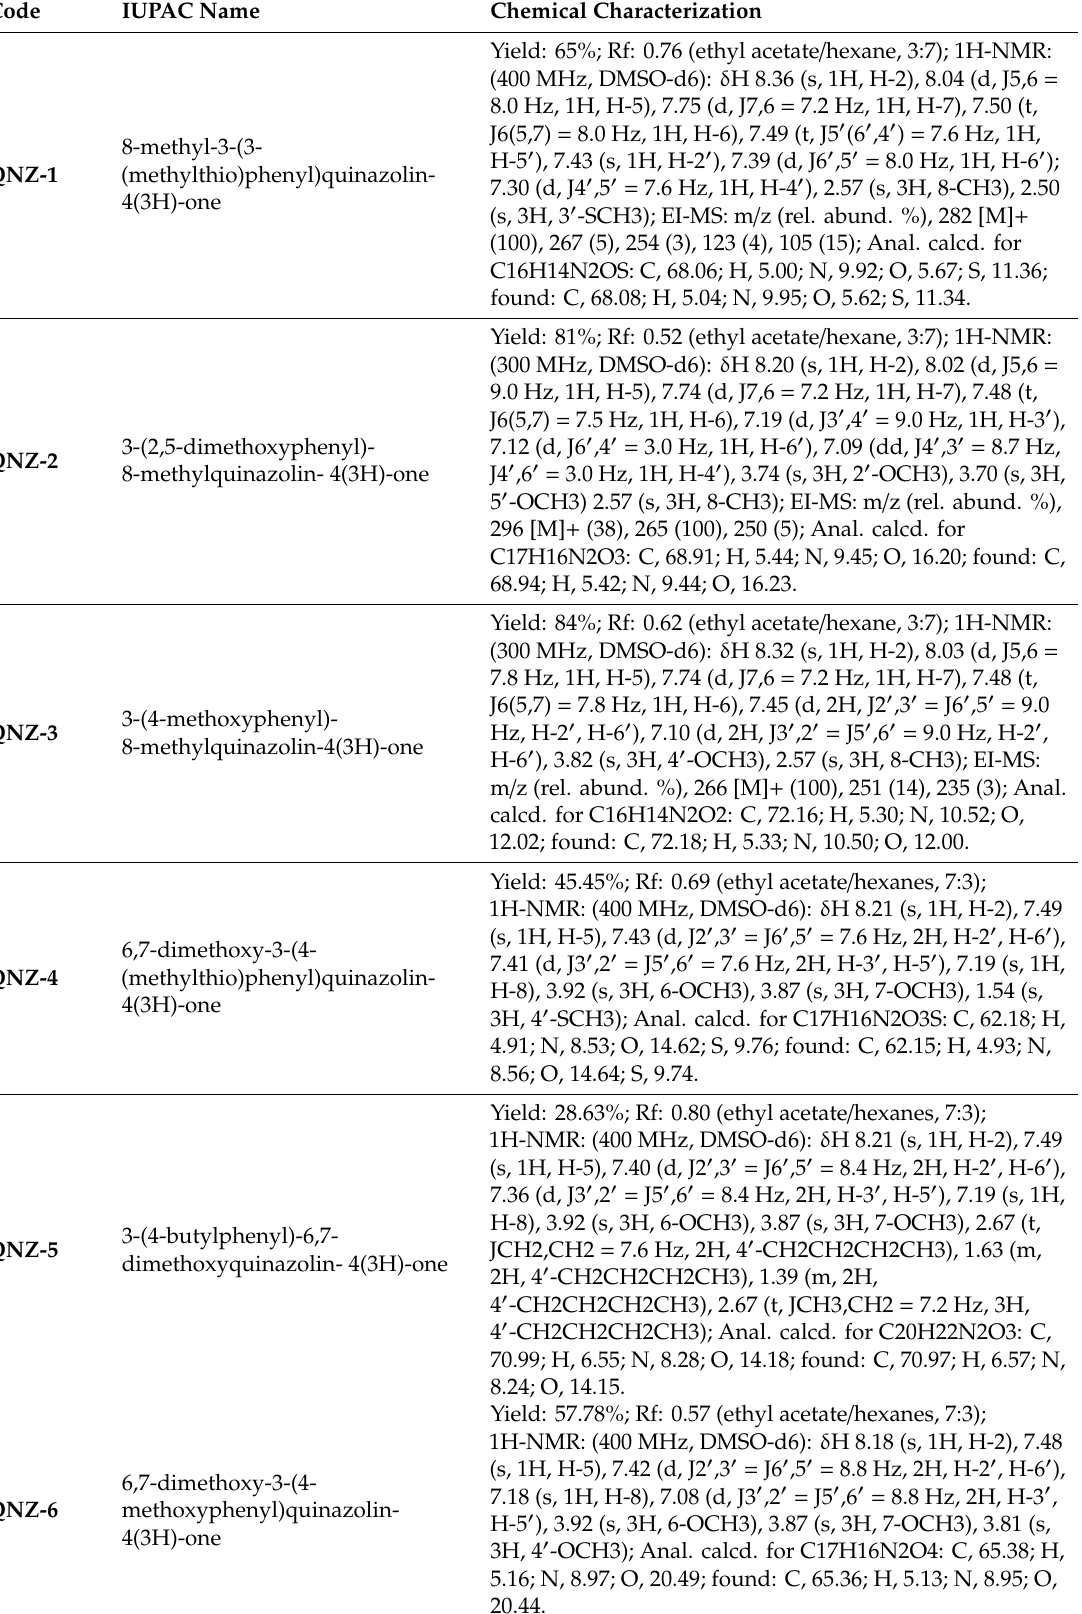
Table 3. H-NMR and EI-MS chemical characterization